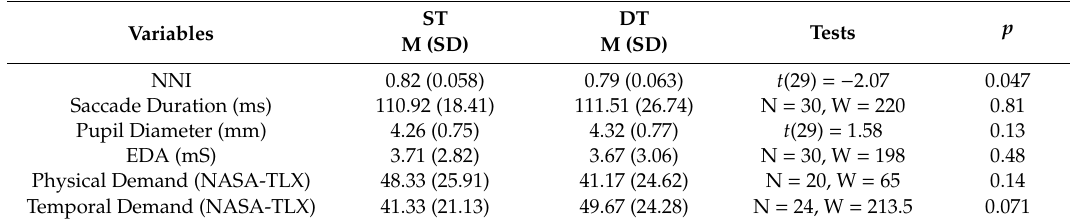
Figure 12. ( a ) Mean perceived effort and ( b ) perceived frustration as a function of task difficulty. *** p < 0.001.